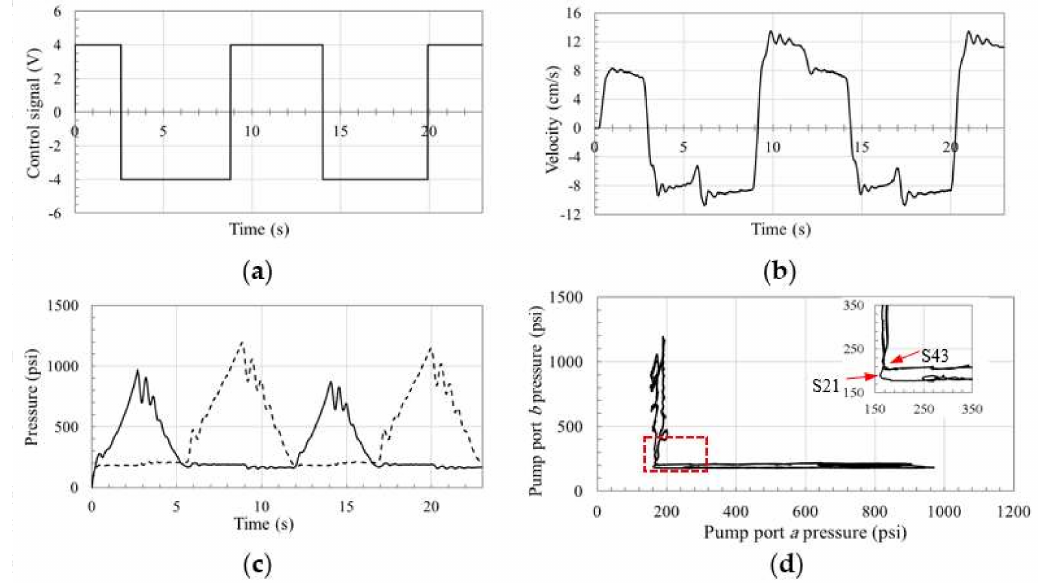
Figure 18. Performance of circuit using OC-SHV for a 368 kg attached mass: ( a ) input control signal; ( b ) actuator velocity; ( c ) pressures at the pump ports a (solid line) and b (dotted line); ( d ) pump pressure